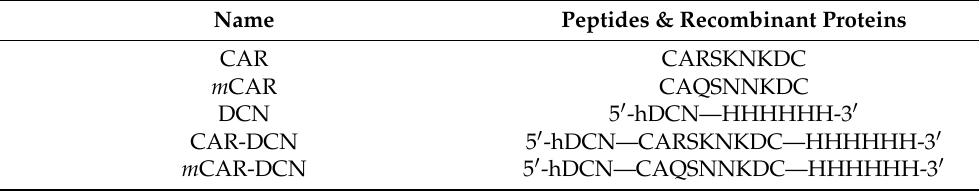
Table 1. The vascular homing peptides and recombinant proteins used. For targeting experiments, the FITC dye was coupled to the synthesized CAR and m CAR (mutant CAR peptide) peptides. For recombinant protein expression, the homing peptide CAR or mutant CAR ( m CAR) was cloned to the C-terminal end of human decorin (DCN). An epitope tag of 6-histidines was also added for purification to the molecule following the CAR sequence. The recombinant proteins were expressed in mammalian expression system and purified by